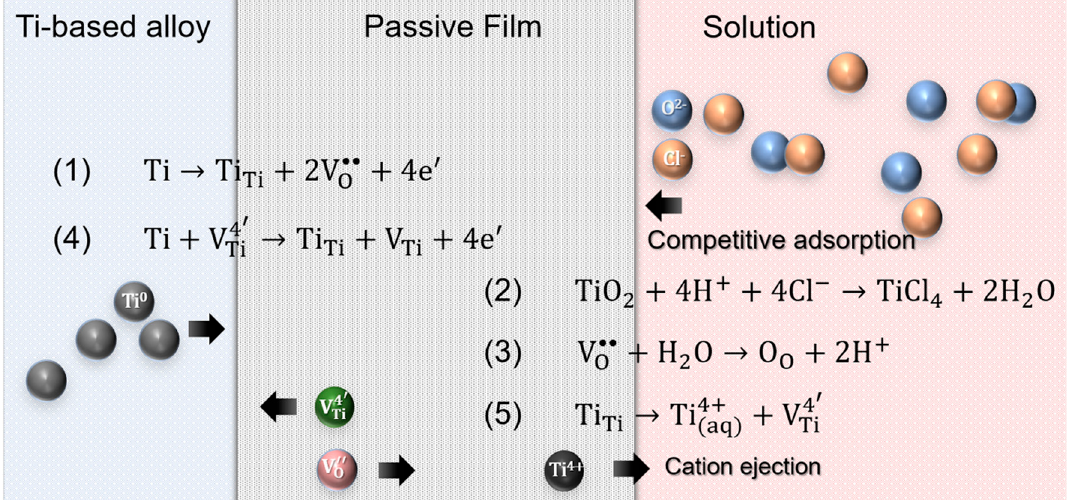
Figure 10. Mechanism of the passive film growth and dissolution according to the point defect model: reactions (1–5) are the physicochemical processes that occur on the passive film. 𝑇𝑖 (cid:3021)(cid:3036) is Ti ions in the cation site of the passive film, Vö is oxygen vacancies in the passive film, 𝑉 (cid:3021)(cid:3036)(cid:2872) (cid:4594) is Ti ion vacancies in the passive film, 𝑉 (cid:3021)(cid:3036) is vacancies in the Ti substrate, 𝑒 (cid:4593) is an electron, 𝑂 (cid:3042) is oxygen ion in the anion site of the passive film, 𝑇𝑖 ((cid:3028)(cid:3044))(cid:2872)(cid:2878) is Ti ions in solution.